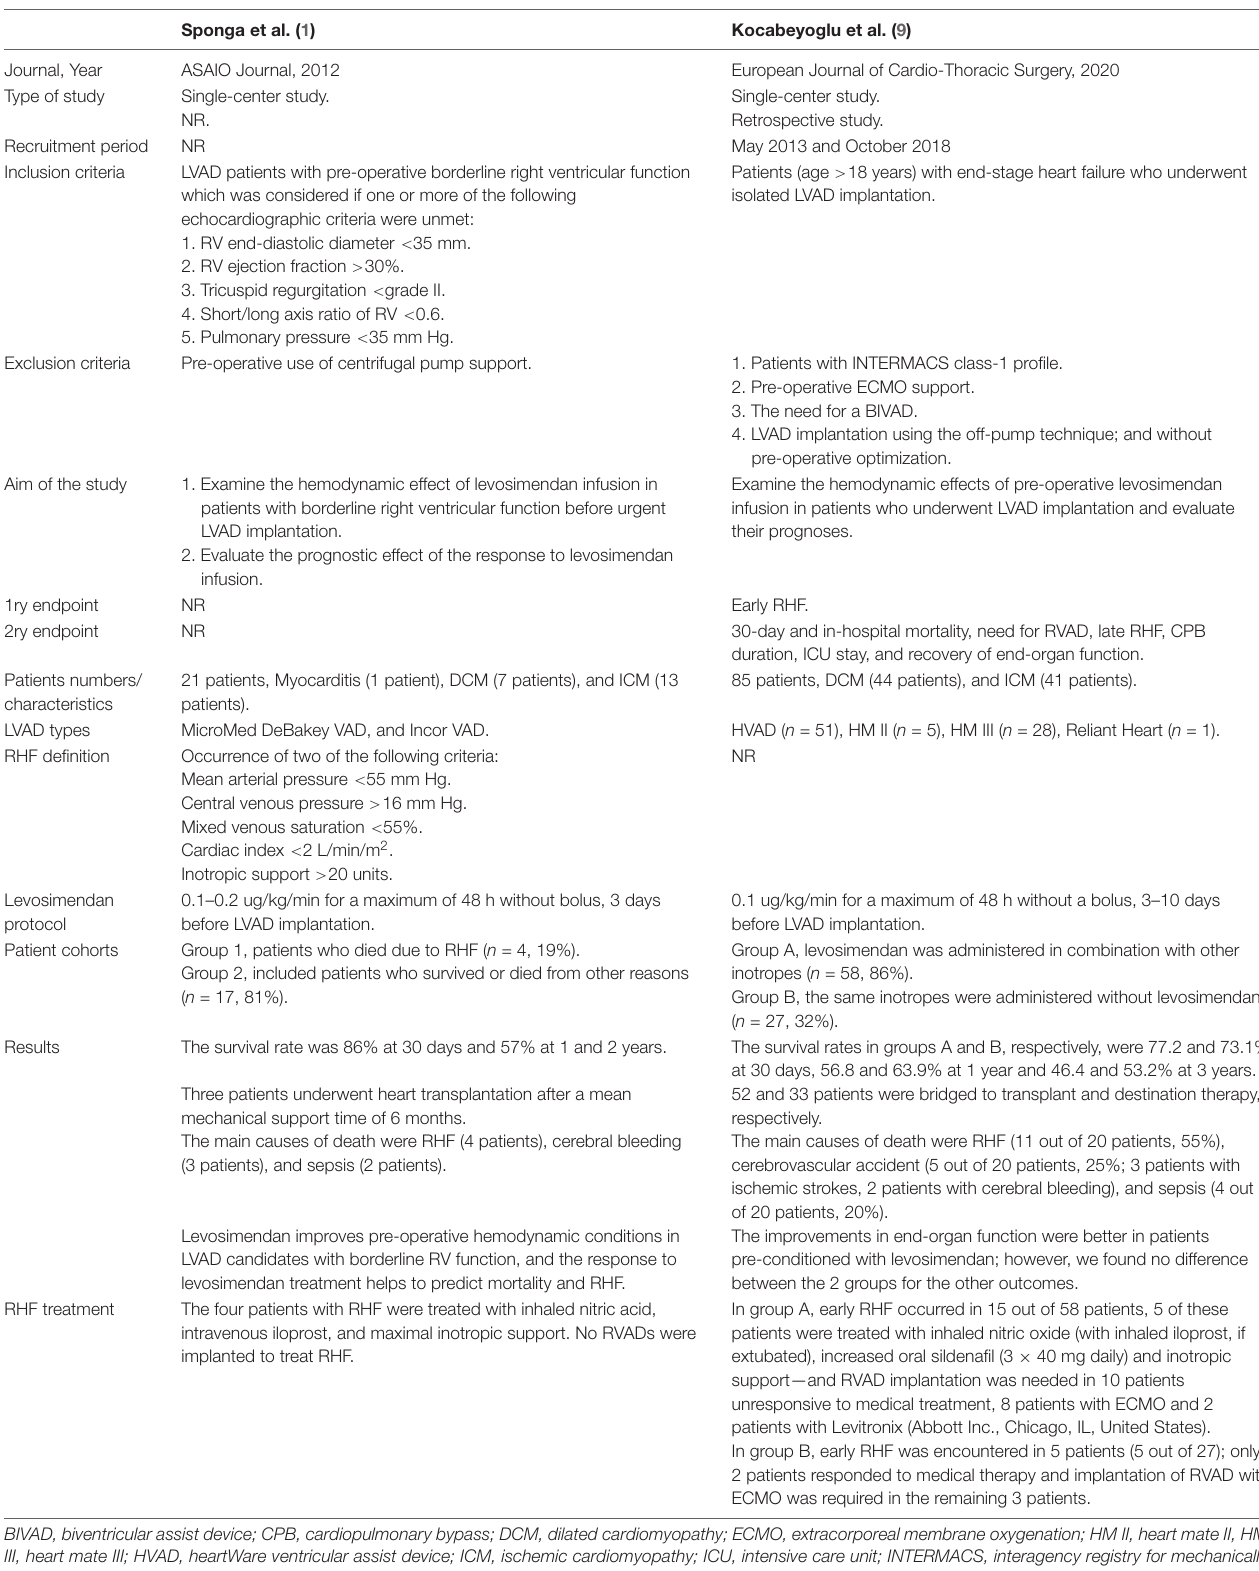
TABLE 1 | Comparsion between the two studies included in the mini-review. Sponga et al.